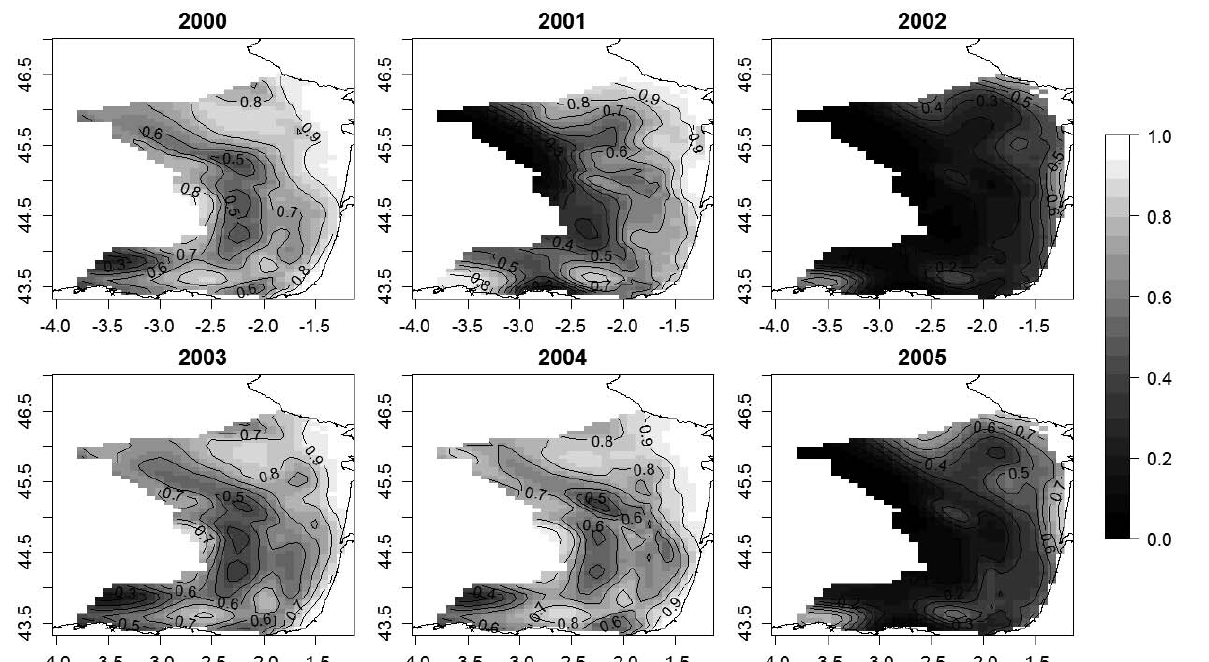
Fig . 7. – Maps of the age-1 proportion from 2000 to 2005 predicted according to the final